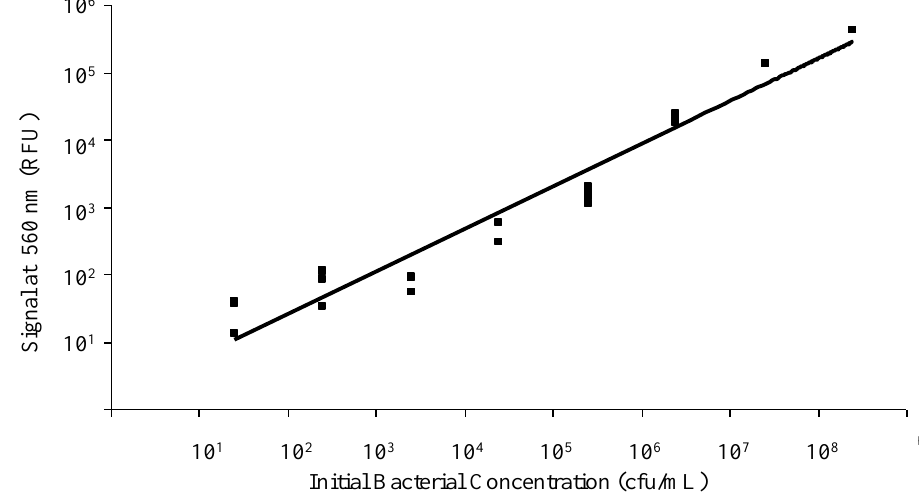
Figure 2. Quantitative Spectrofluorometry. Correlation of bacterial concentration and background subtracted (background = HEX probe signal with no bacterial DNA or donor dye present) FRET-ISH signal (acceptor dye emission at 560 nm) as recorded by the Nanodrop 3300.